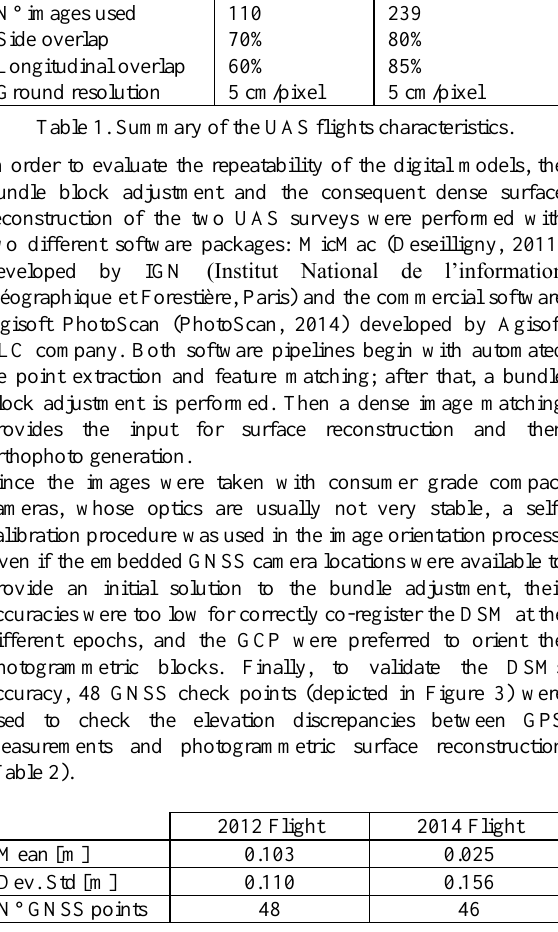
manual measurements revealed significant surface